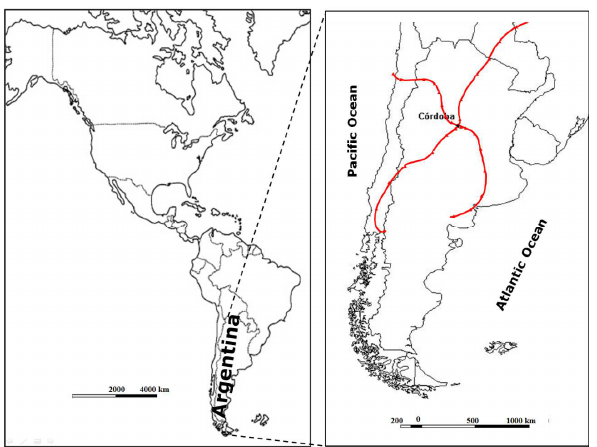
Figure 4. Location of Argentina and air mass pathways of different quadrants: northwest, northeast, southwest and